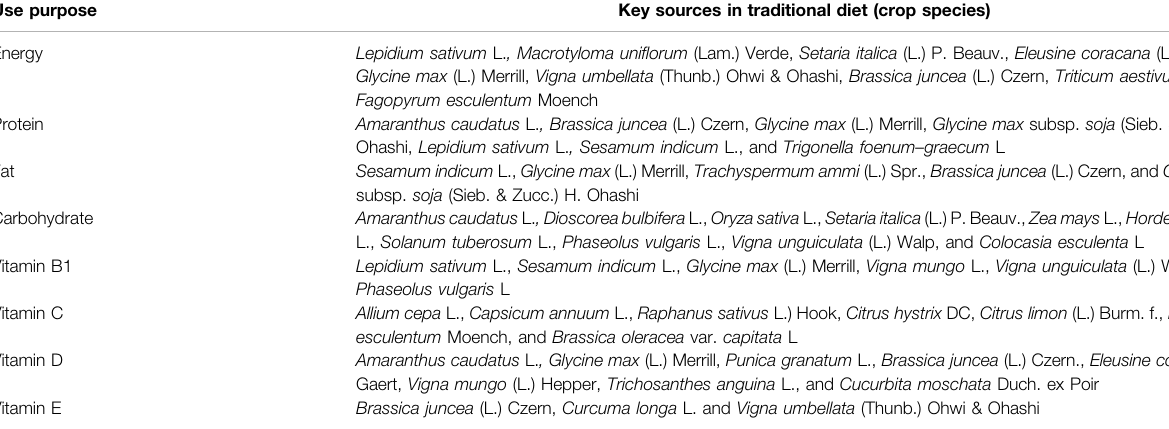
TABLE 5 | Dietary diversity at the household level in central Himalaya. Food groups (12-FGI)